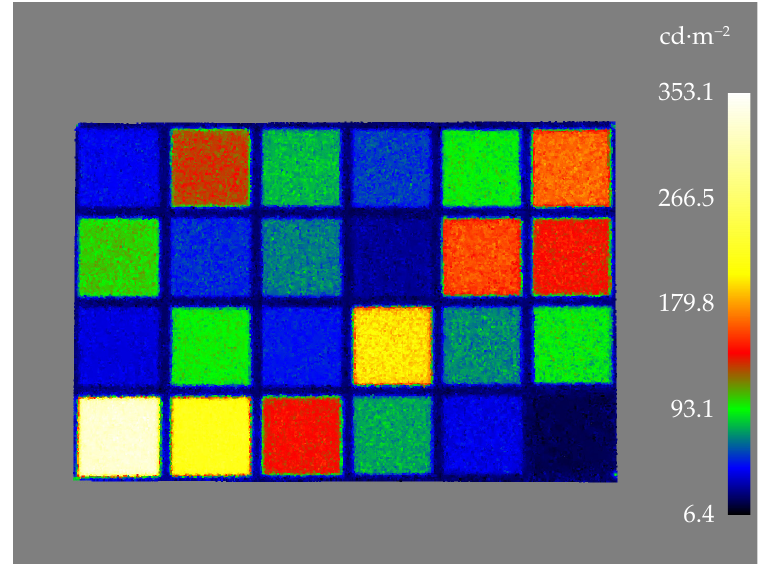
Figure 10. Luminances of the measured color target X-Rite ColorChecker Classic. The patches in the lowest row of patches (1–6) are the grayscale patches used for luminance